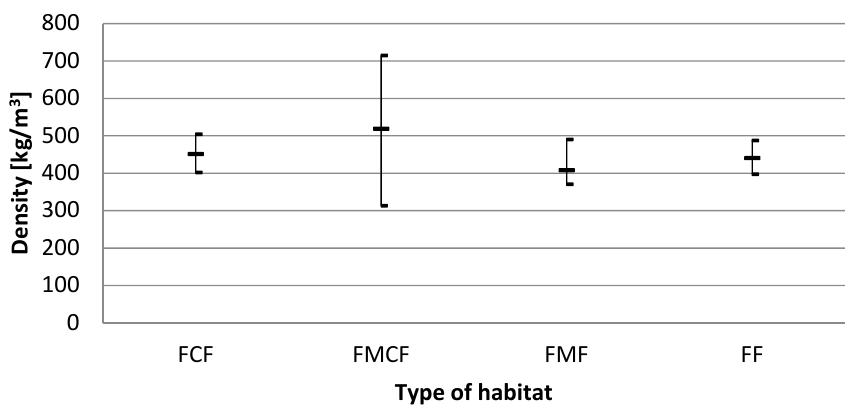
Figure 2. The average density of wood collected from different types of forest habitat ( Source: Author’s original compilation ).